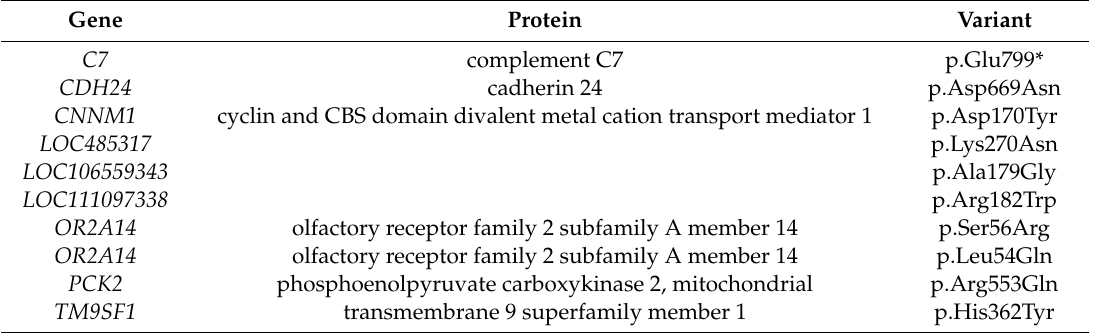
Table 3. Heterozygous protein-changing variants shared by the 2 PED cases and absent in 654